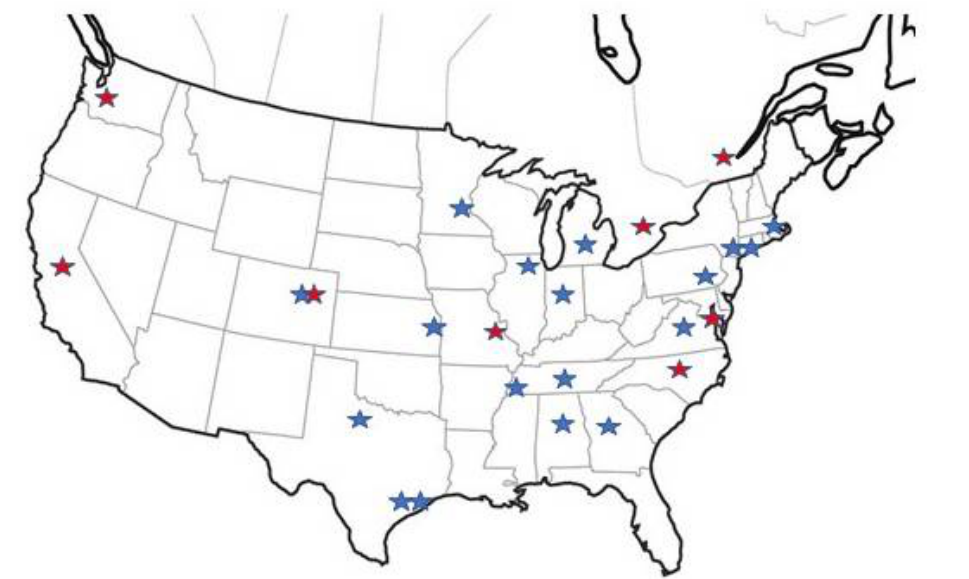
Figure 4. Map of PCD Foundation accredited clinical centers in the United States and Canada. Location of centers represented by stars. Red stars represent the original PCD centers of the Genetic Disorders of Mucociliary Clearance. Blue starts represent new centers that have been added since the formation of PCDF CRCN and creation of diagnostic guidelines.